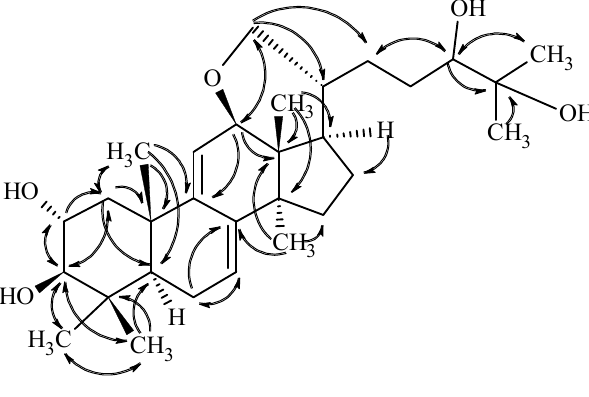
Figure 2. Key HMBC correlations of compound 1.